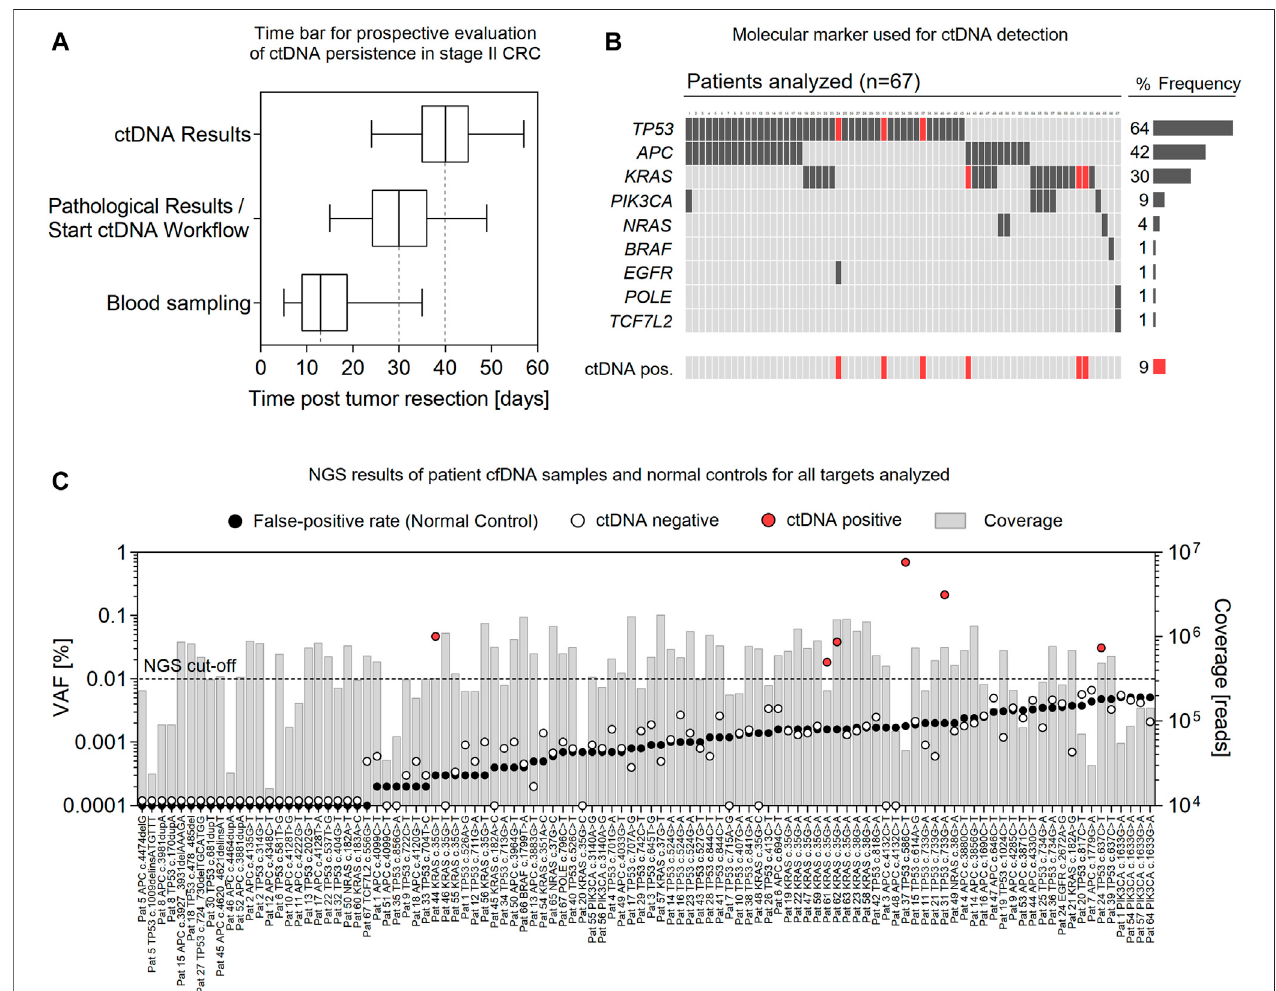
FIGURE 3 | Rapid prospective evaluation of ctDNA persistence in stage II CRC. (A) Time bar showing intervals of blood sampling, pathological analysis of primary tumor material, and ctDNA analysis post-tumor resection of stage II CRC patients ( n (cid:1) 67). Box plots represent median values with interquartile range; Box – Whiskers represent min. to max. values. (B) Molecular marker (and frequency) used for ctDNA analysis and samples positive for ctDNA (red). (C) NGS results of all ctDNA targets analyzed ( n (cid:1) 104) and corresponding false-positive rates (black) of individual mutations. Bars represent the sequencing coverage of each sample. ctDNA positive samples are presented in